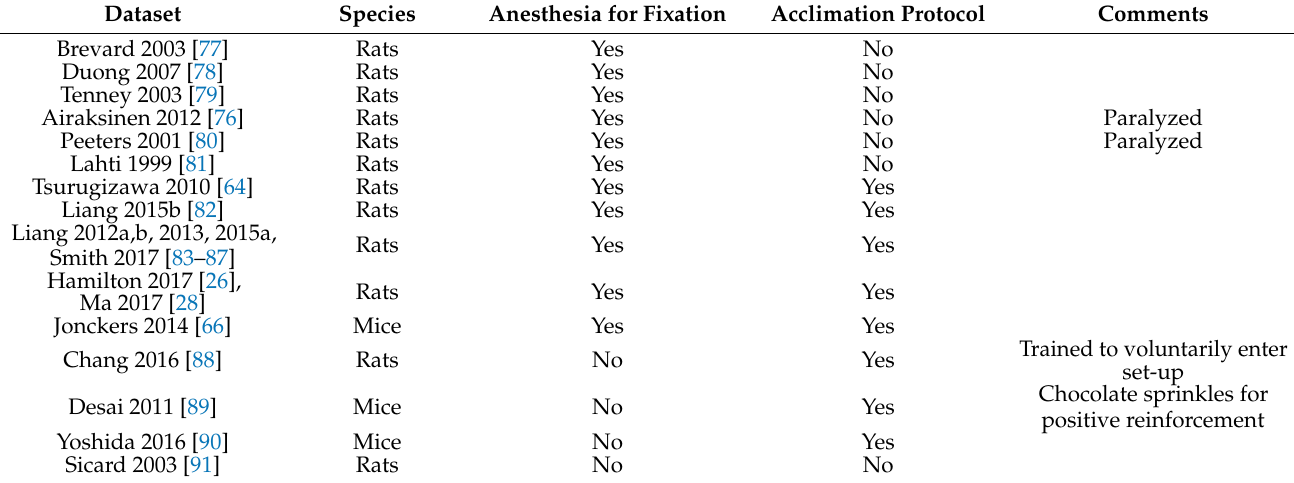
Table 2. Protocols for awake imaging in studies comparing awake and anesthetized imaging. Dataset